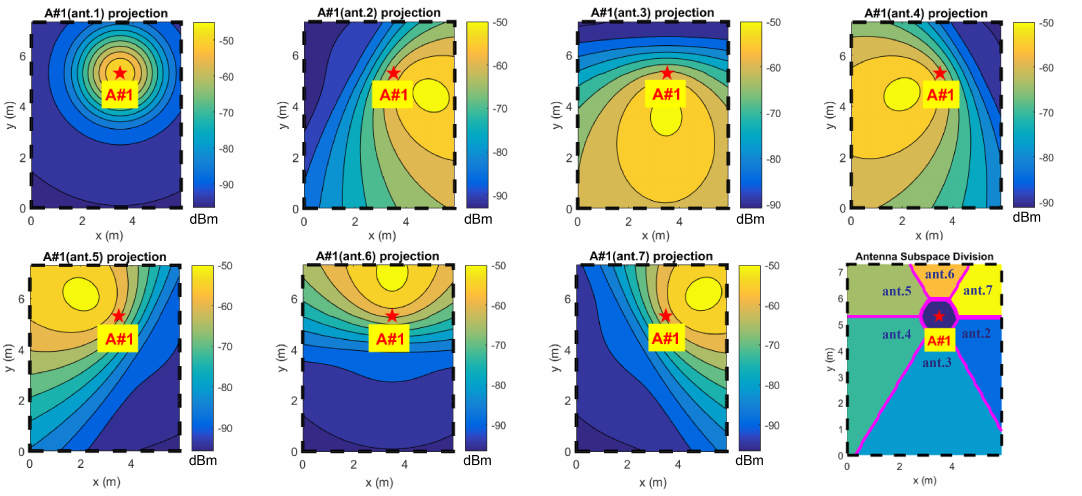
Figure 6. Predicted fingerprinting map for the first anchor node.